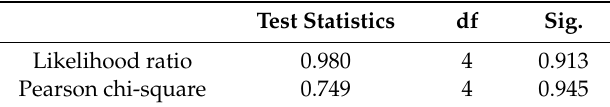
Table 6. Goodness of fit results for the model.